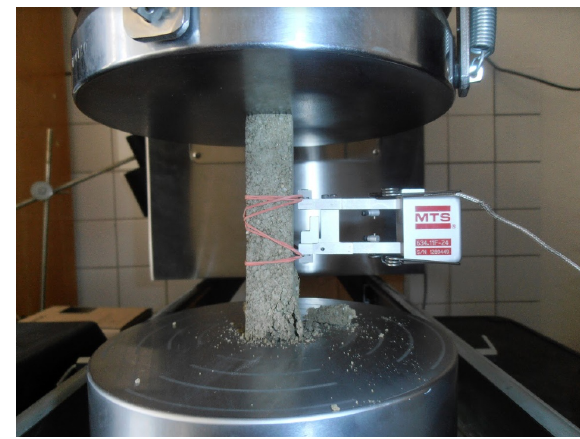
Figure 6. Testing of specimens: compressive